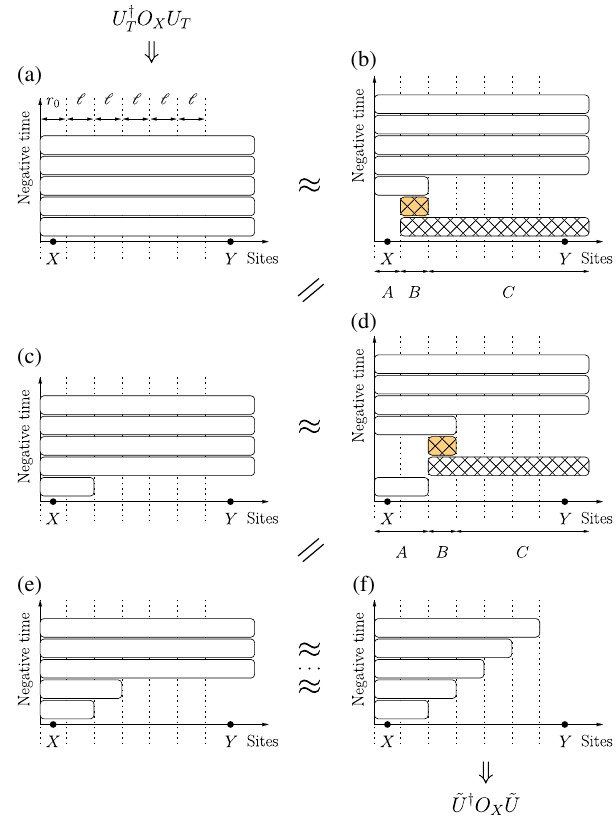
˜ U FIG. 2. A step-by-step construction of the unitary such that ˜ U ≈ U † ˜ U † O O U . Each box represents an evolution of the X X T T subsystem covered by the width of the box for a fixed time. The colors of the boxes follow the same convention as in Fig. 1. In panel (a), the unitary U is written as a product of evolutions of T the same system in M ¼ 5 consecutive time slices. (b) The evolution in the last (bottom) time slice is decomposed using the method in Fig. 1, with the choice of subsystems A , B , C such that X is contained in A . The evolutions of the subsystems B and BC (hatched boxes) therefore commute with O and cancel out with X , resulting in (c). In panel (d), we their counterparts from U † T repeat the procedure for the second-from-bottom time slice, but note the different choice of A , B , C from (b). This difference is necessary to ensure that the evolutions of B and BC commute with the evolution(s) from the previously decomposed time slice(s). We then commute them through O again and remove X ˜ U them from the construction of in (e). Repeatedly applying the unitary decomposition for the other time slices, we obtain ˜ U the unitary in (f), which is supported on a smaller region than the original unitary U . With a proper choice of the size l of T B , we can make sure that Y lies outside this region, and, therefore, ˜ U commutes with O Y